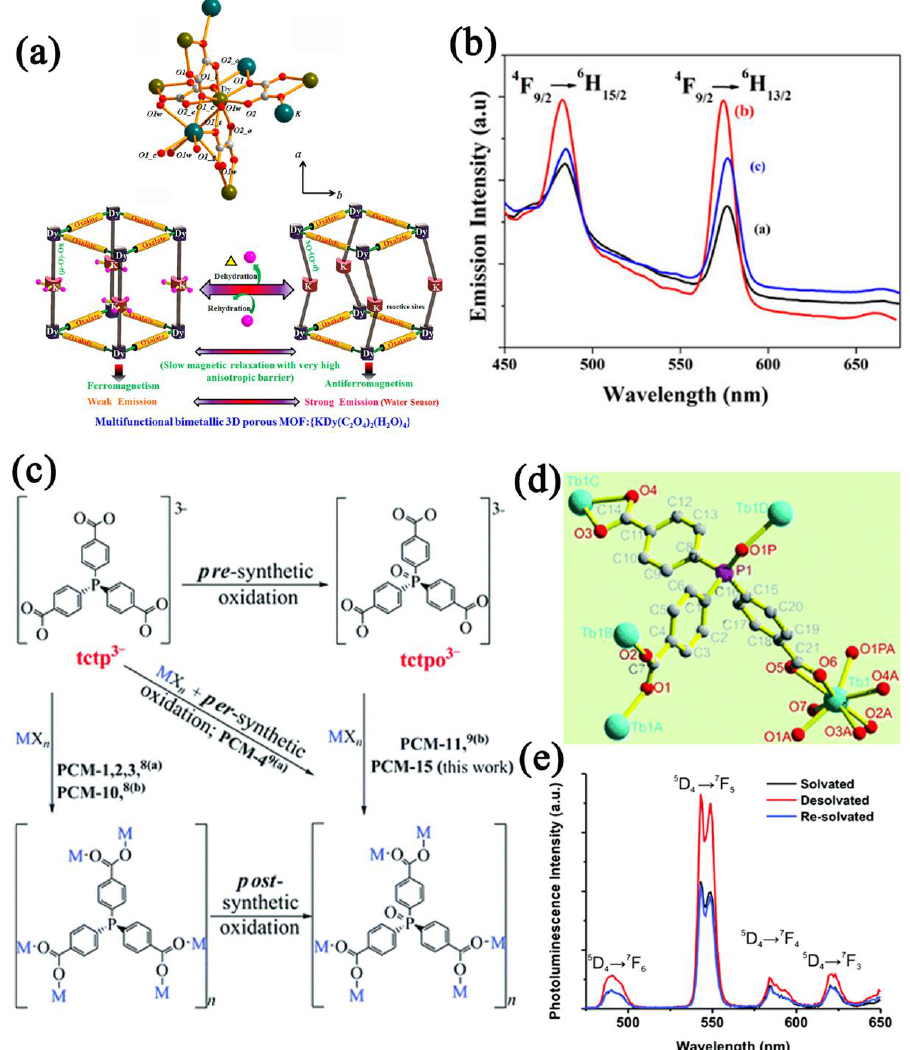
Figure 13. ( a ) Coordination environment and water − induced structural change of Dy − MOF. ( b ) Luminescent spectra ( λ ex = 365 nm) of Dy − MOF − based sensor to water (original ( a , black line), dehydrated ( b , red line), rehydrated ( c , blue line)). Reproduced with permission from Ref. [123]. Copyright 2013, American Chemical Society. ( c ) Different methods to introduce the P=O group to prepare PCM − 15. ( d ) Coordination environment of PCM − 15. ( e ) Photoluminescence spectra for solvated, desolvated, and rehydrated PCM − 15 − based sensor ( λ ex = 330 nm). Reproduced with permission from Ref. [124]. Copyright 2015, The Royal Society of Chemistry.